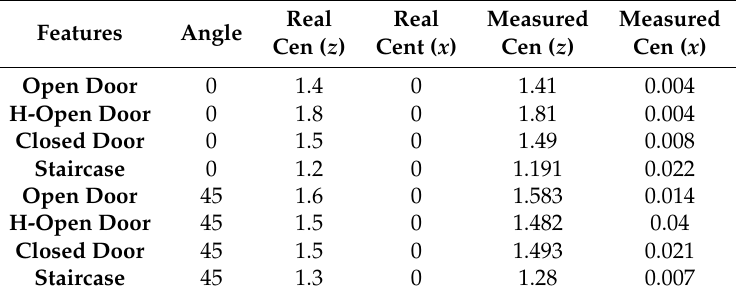
Table 3. Mean measured distances (in meter).